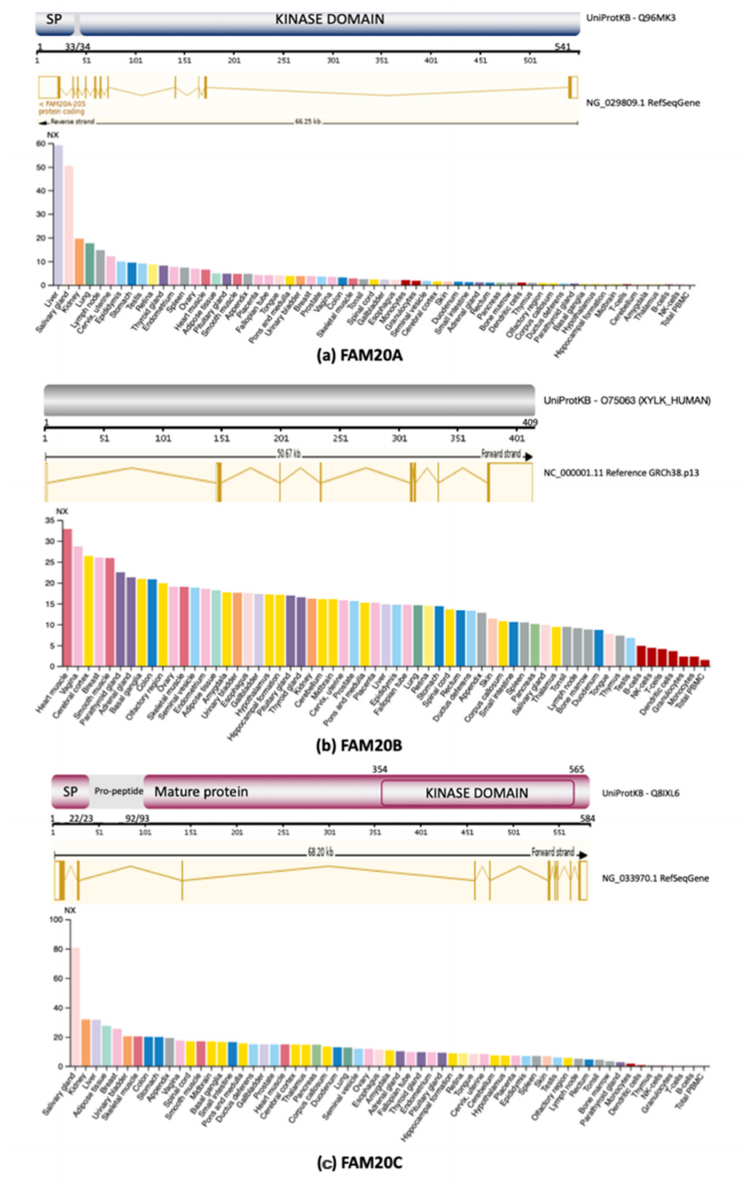
Figure 1. Members of FAM20C family. Protein structure at the top, gene structure in the middle and RNA expression in different tissues in the bottom: ( a ) description of FAM20A; ( b ) description of FAM20B; ( c ) description of FAM20C. Gene structure of each gene was obtained from Ensemble release 104—May 2021 (Access date: 1 June 2021). RNA expression from consensus transcript expression levels from The Human Protein Atlas (https://www.proteinatlas.org/ENSG00000108950 -FAM20A/tissue, https://www.proteinatlas.org/ENSG00000116199-FAM20B/tissue, https://www. proteinatlas.org/ENSG00000177706-FAM20C/tissue) version 20.1 and Ensembl version 92.38. NX: consensus normalized expression value for each gene (access date: 15 June